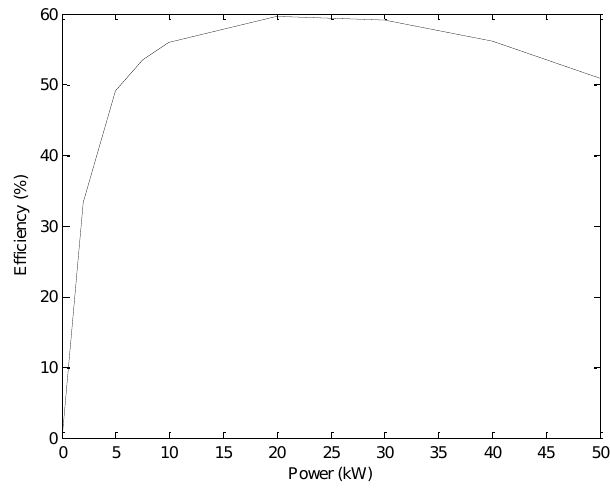
Figure 2. Power–efficiency curve for the fuel Figure 2. Power – efficiency curve for the fuel cell.